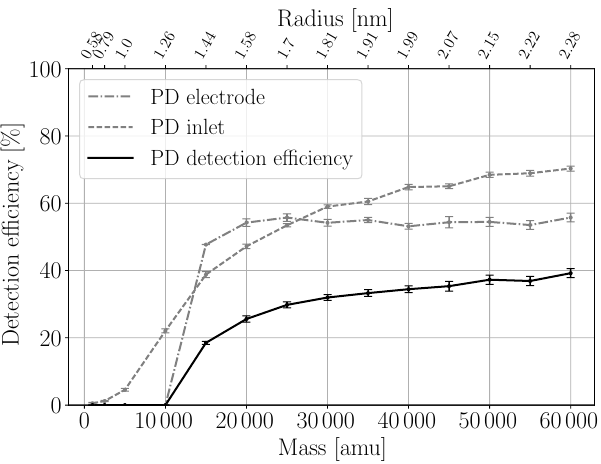
Figure 5. PD detection efficiency (black solid line) at 82km as a function of particle mass (radius) by means of the product of the probabilities of particles reaching the inlet (dashed grey line, from Fig. 3) of the PD and its electrode (dashed dotted grey line) as well as the corresponding error bars. Note that uncertainties due to, for example, particle structure and payload charging are not considered. The error bars therefore only contain the statistical uncertainty of the